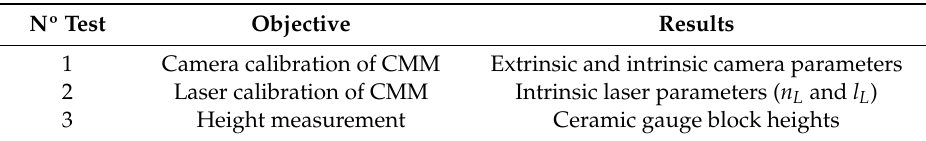
Table 2. Summary of experiments.